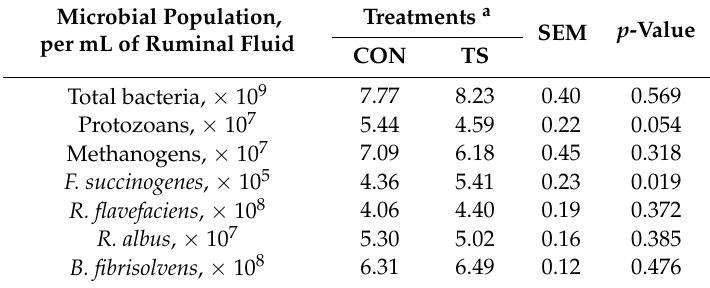
Table 5. Effects of tea saponin (TS) supplementation on ruminal microbial population. Microbial Population, Treatments per mL of Ruminal Fluid